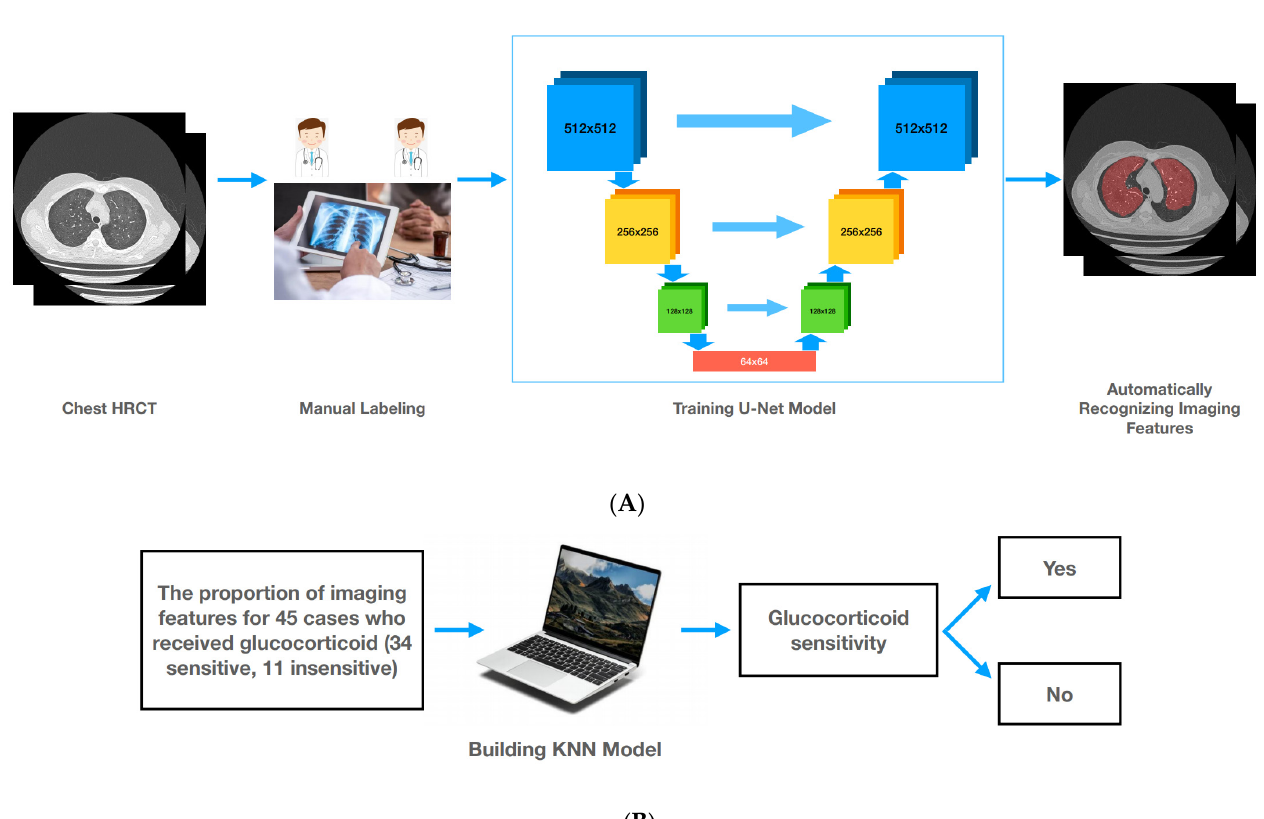
Figure 2. ( A ) The flowchart for developing a U-net model to automatically recognize imaging features. Chest HRCT, chest high-resolution computed tomography. Two radiologists labeled the chest HRCT of 150 IIP patients. Then, we developed a U-net model to recognize imaging features. When we placed one patient’s chest HRCT into the model, the model could recognize the different imaging features automatically. ( B ). The flowchart for developing a KNN model to automatically judge glucocorticoid sensitivity. KNN, k-nearest neighbor. The proportion of imaging features for 45 cases was calculated automatically. When we placed one patient’s chest HRCT into the artificial intelligence model which included the U-net model, automatic calculation, and the KNN model, it could firstly recognize imaging features and then calculate the proportion of imaging features, and finally judge the glucocorticoid sensitivity.